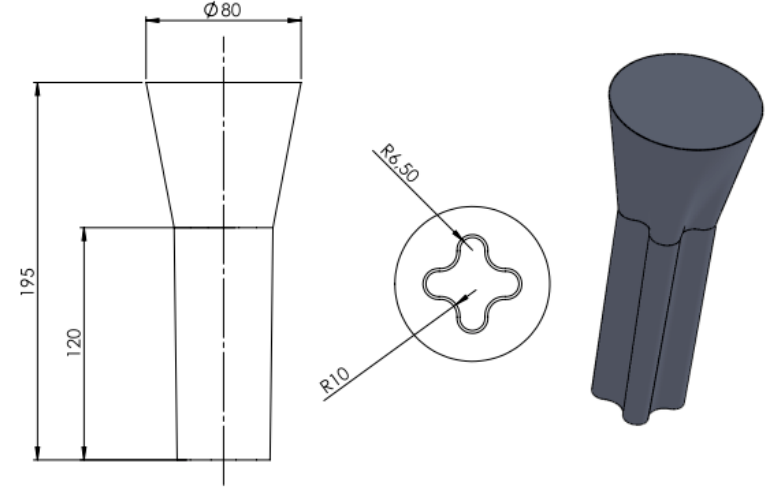
Figure 1. Dimensions of the wax-model.